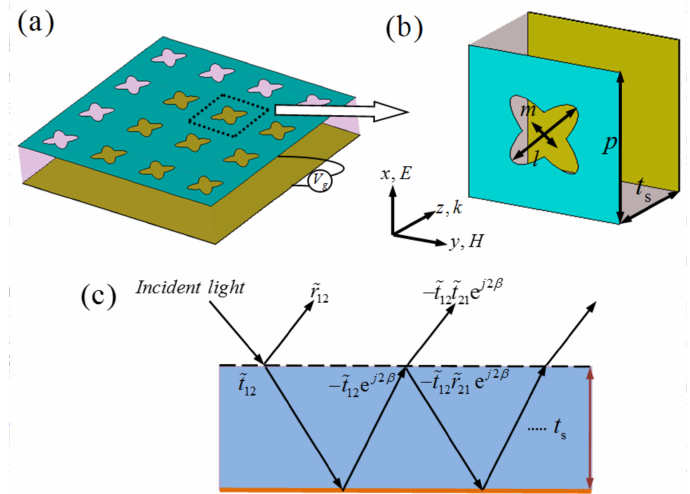
Figure 1. The scheme of designed THz MMA: ( a ) the period array and ( b ) unit-cell structure; ( c ) the interference